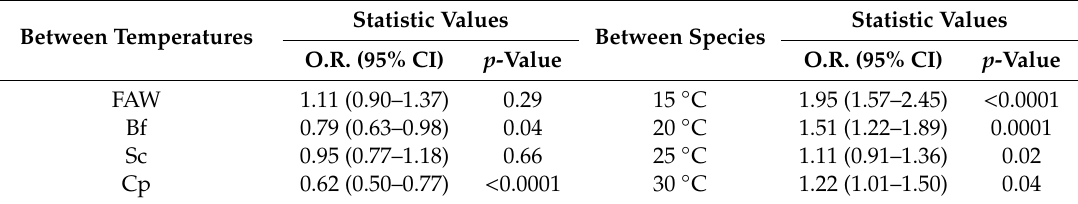
O.R. = odd ratios, CI = confidence interval, FAW = Spodoptera frugiperda , Bf = Busseola fusca , Sc = Sesamia calamistis , Cp = Chilo partellus. Table 2. Result of ANOVA comparing relative growth rates of each single-species at di ff erent constant temperature and at each temperature between species. Statistic Values Statistic Values Between Temperatures Between Species F p -Value F p -Value FAW 19.14 < 0.0001 15 ◦ C 0.35 Bf